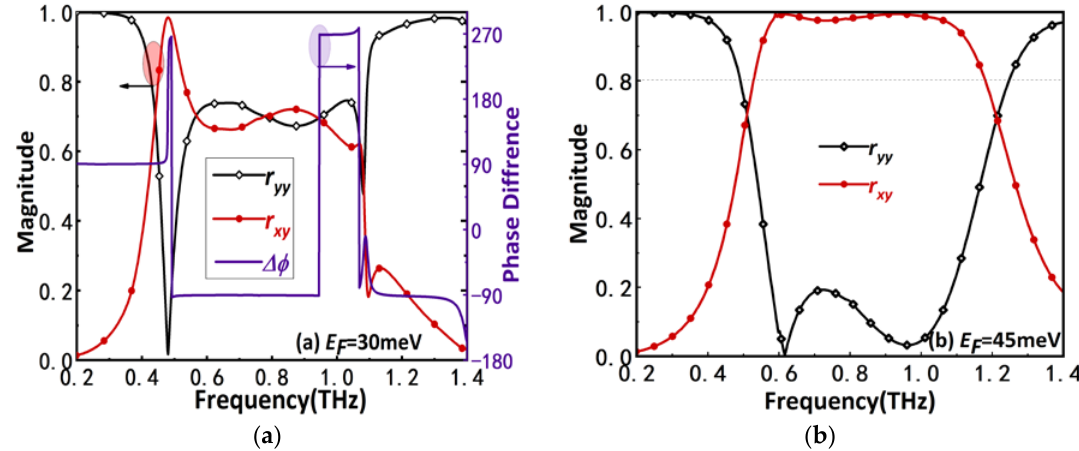
Figure 3. Reflective coefficients ryy and rxy with the Fermi energy of ( a ) 30 meV and ( b ) 45 meV.